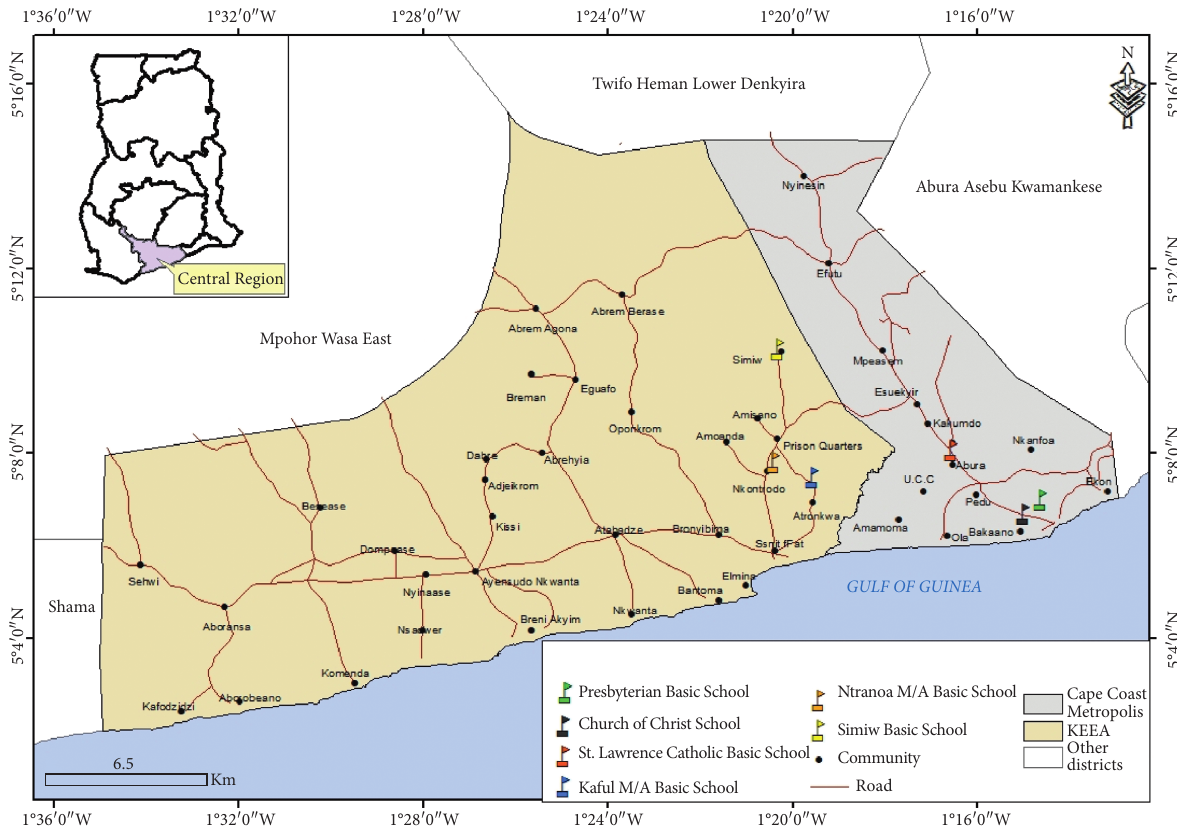
Figure 1: Map of Ghana showing the location of the selected schools within the Central Region created using shapefiles from the Survey Department of the Ghana Statistical Services and ArcMap GIS v10.5 (no administrative permissions were needed to access the shapefiles). Courtesy: Mr. Richard Adade, GIS and Remote Sensing Unit, Department of Fisheries and Aquatic Sciences, Center for Coastal Man- agement, University of Cape Coast, Cape Coast,